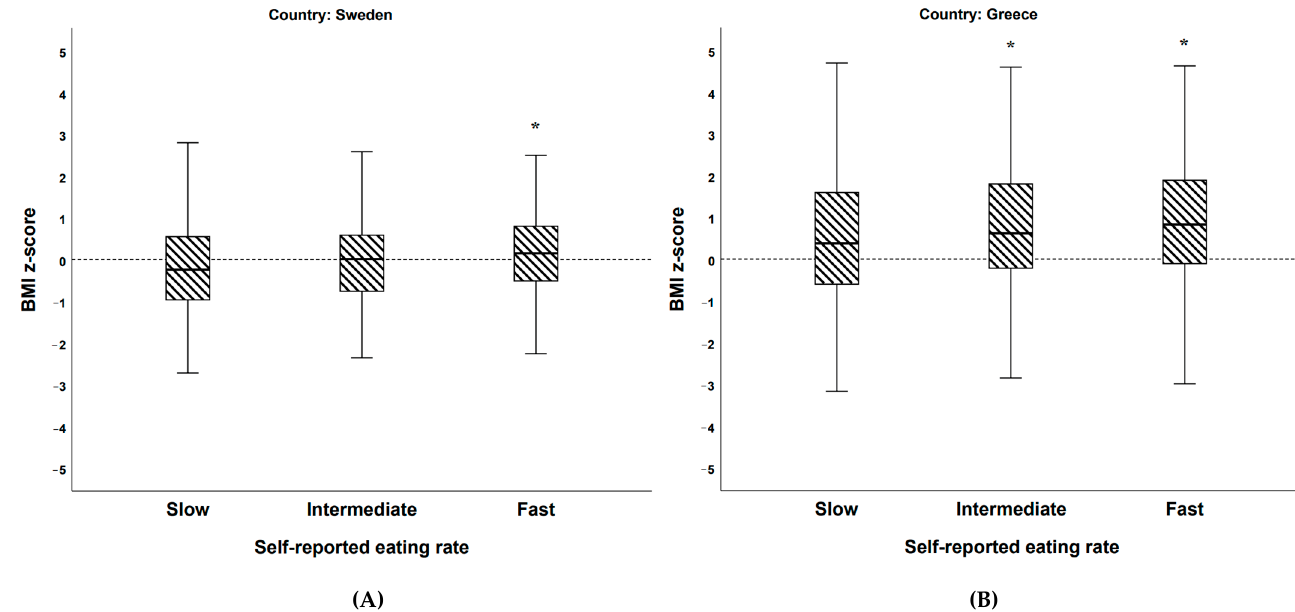
Figure 10. ( A , B ) Boxplots illustrating BMI z-scores among ( A ) self-reported eating rate categories among Swedish ( A , n = 748) and ( B ) Greek ( B , n = 1084) students in the BigO cohort. * = significantly different vs. self-rated slow eaters.